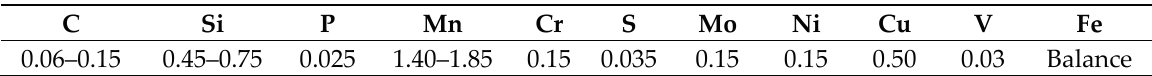
Table 2. Chemical composition of filler wire